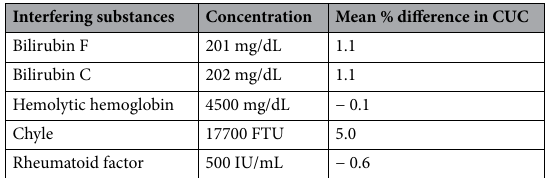
Table 2. Interference testing with bilirubin, hemoglobin, chyle, and rheumatoid factor.